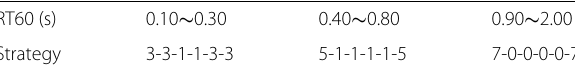
Table 2 RT60-dependent temporal-spatial